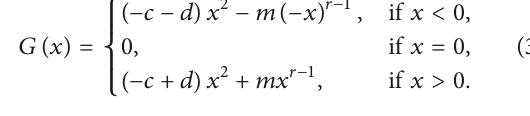
Figure 1: Projections of the attractor related to the hyperchaotic system (1) onto the spaces (𝑥,𝑦, 𝑧) , (𝑥,𝑦) , (𝑥,𝑧) , (𝑦,𝑧) , and (𝑤,𝑦) . ̇𝑧 = −𝑎𝑧 − 𝑏𝑦 + 𝐺